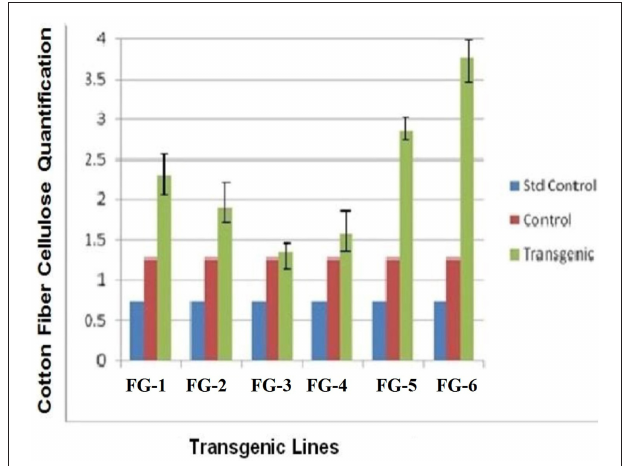
FIGURE 6 | Comparison of cellulose contents of transgenic and control cotton fiber along with standard control. Plants in groups 1 to 6 were showed three different samples of cellulose. Blue color represent the amount of cellulose from Avicel PH-101pure cellulose, red color represent the amount of cellulose obtained from untransformed cotton, green color indicated the depicts the presence of cellulose in transgenic cotton.